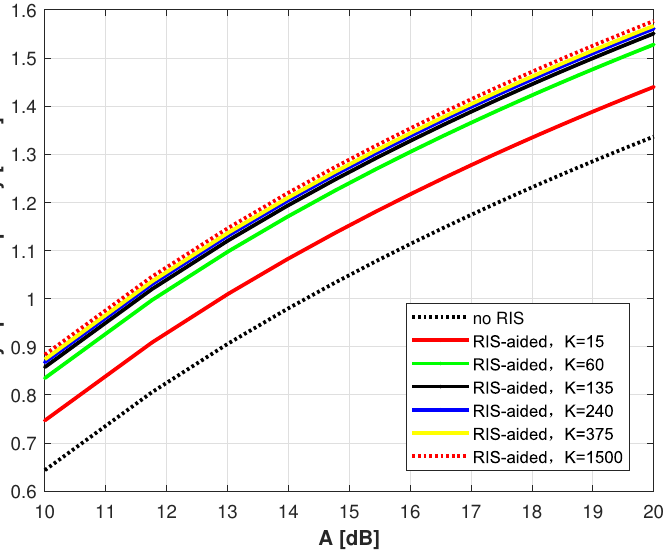
Figure 3. Asymptotic capacity of MISO-VLC channel in High-SNR scenario versus SNR with different number of